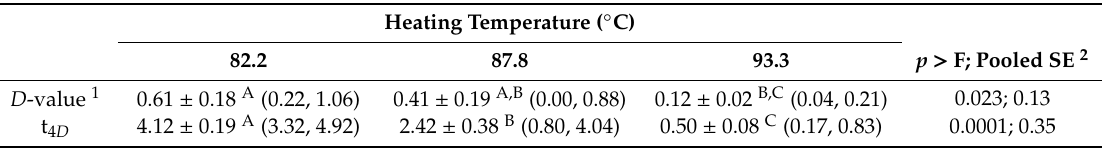
Table 1. Least squares means of D - (min) and t 4 D values (min) for Salmonella inoculated into whole chicken blood and heated to di ff ering target